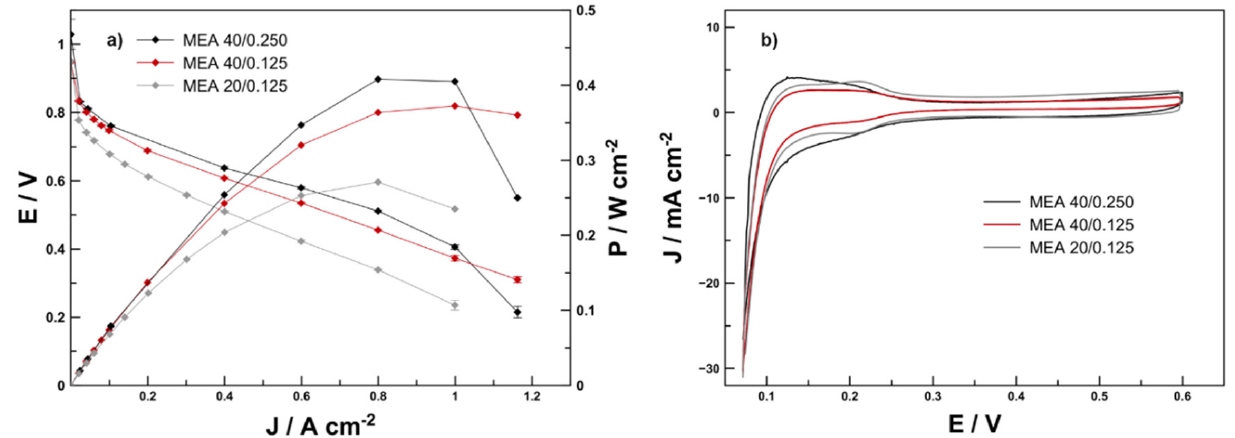
Figure 5. Polarization curves recorded using H2/SA 600 mL min − 1 fixed flow at 60% RH and 1.5 bar (g) ( a ) and in-situ ECSA measurement recorded using H 2 /N 2 at 100% RH and atmospheric pressure ( b ) of the investigated MEAs. Error bars in polarization data represent the deviation of cell potential signals over the recording period.